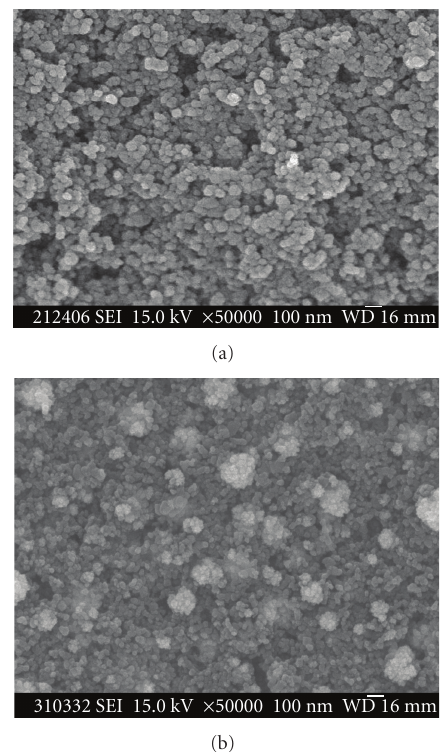
Figure 3: SEM images of TiO 2 and Pt-TiO 2 films (a) TiO 2 film and (b) Pt-TiO 2 with 1.8 wt.% Pt.